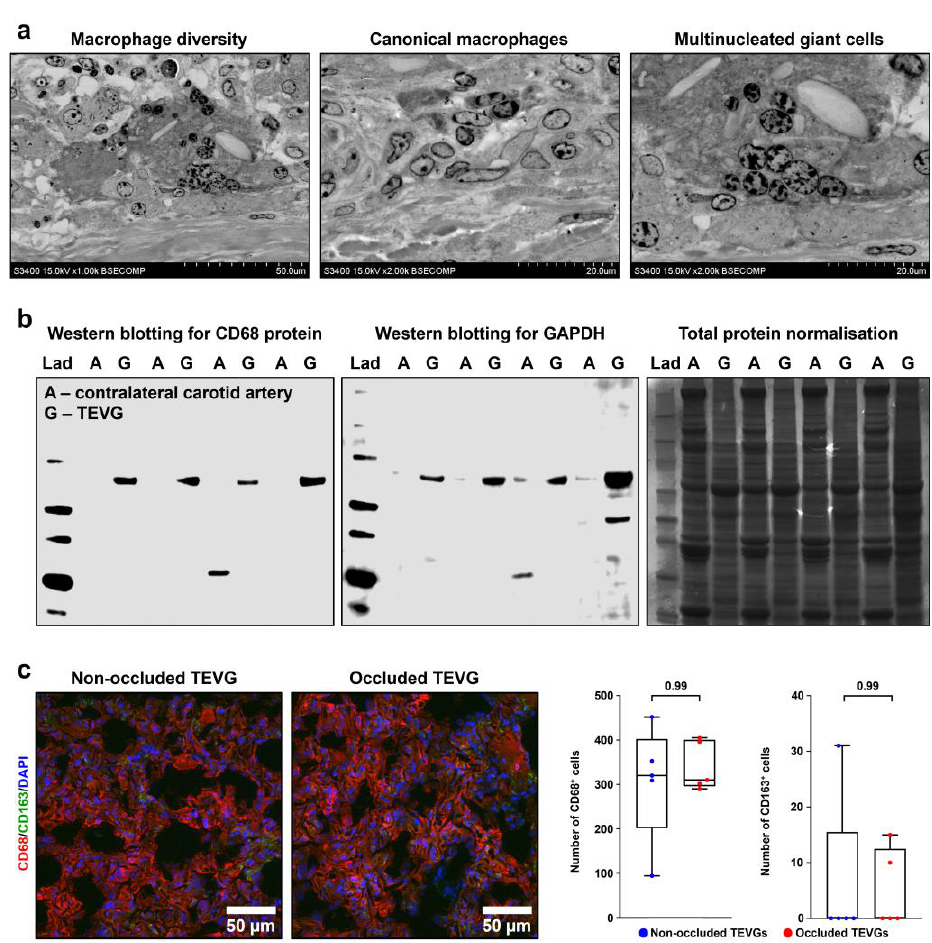
Figure 11. TEVGs but not intact contralateral carotid arteries are infiltrated by macrophages. ( a ) Backscattered scanning electron microscopy (EM-BSEM) shows massive macrophage invasion within the tunica adventitia of the TEVG. Left: overview of invading macrophages; centre: canonical macrophages; right: multinucleated giant cells. Magnification: × 1000 (left) and × 2000 (centre and right), scale bar: 50 and 20 µ m respectively, accelerating voltage: 15 kV. ( b ) Western blotting of TEVG and contralateral carotid artery lysate for CD68 protein, representative image (left) and for glyceraldehyde 3-phosphate dehydrogenase (GAPDH), representative image (centre), and loading control by Coomassie Brilliant Blue staining (right). ( c ) Immunofluorescence staining for the pan- macrophage marker CD68 (red colour) and M2 macrophage marker CD163 (anti-inflammatory and pro-fibrotic macrophage specification, green colour). Magnification: × 400, scale bar: 50 µ m. Nuclei are counterstained with DAPI. Representative images (left) and semi-quantitative analysis (right). Each dot on the plots represents the measurement from one image (n = 5 images per group). Whiskers indicate the range, box bounds indicate the 25th–75th percentiles, and centre lines indicate the median. p values are provided above boxes, Mann–Whitney U